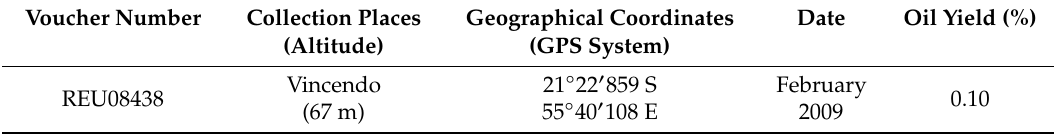
Table 12. Sampling data of the studied Dodonea viscosa and percentage yield of the essential oil. Voucher Number Collection Places Geographical (Altitude)